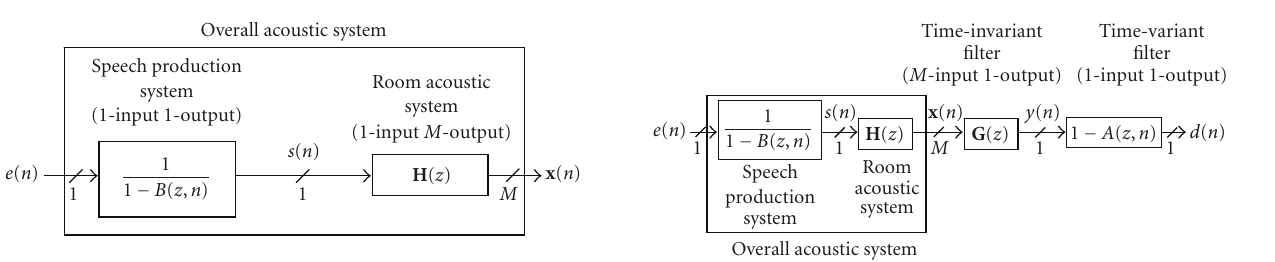
Figure 2: Schematic diagram of global system from innovations process to its